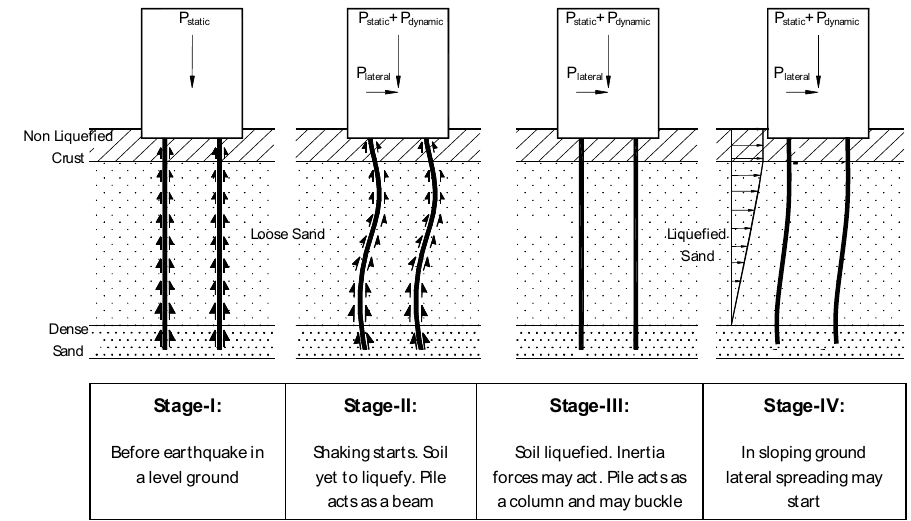
Fig. 3. Different stages of the loading on a pile in liquefiable